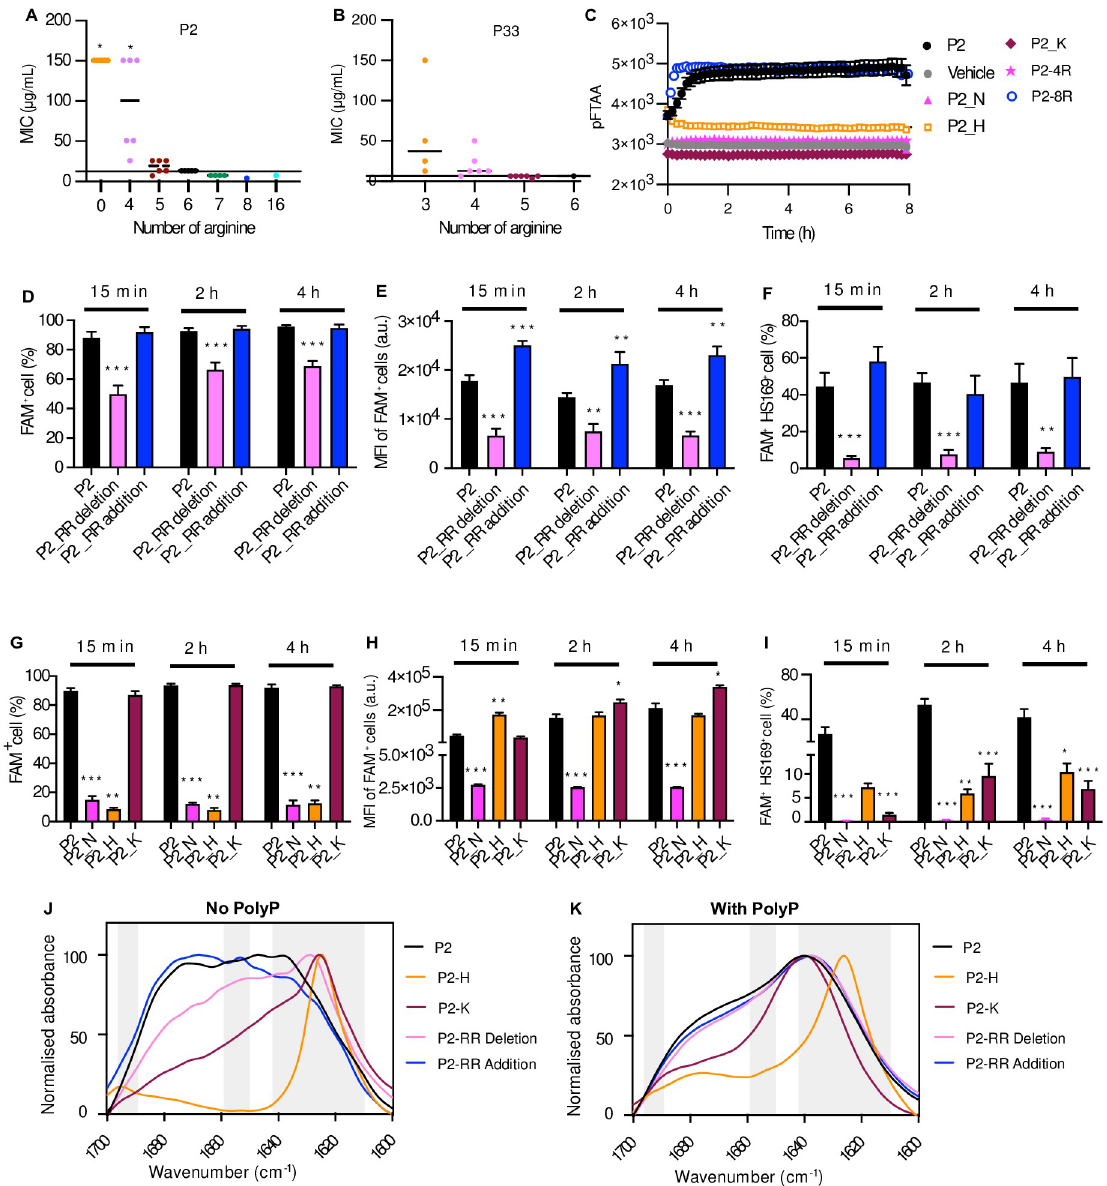
Fig 1. Arginine is essential for Pept-in mediated antimicrobial activity. A-B: MIC of P2 ( A ) and P33 ( B ) variants generated by modifying the amount of arginine against E . coli BL21. These two figures are associated with data from S1 and S2 Tables, respectively. Each dot represents the MIC of one Pept-in design. C: Time dependence of pFTAA (0.5 μ M) fluorescence intensity of P2 derivatives (50 μ M) in the presence of polyP (0.5 mM). (Error bars represent SEM, n = At least 3). D-I: Flow cytometry analysis of E . coli BL21 treated with FAM- labelled Pept-ins for different time points from three independent experiments. Samples from D-E were acquired using BD Fortessa X-20, whereas samples from G-I were acquired using Gallios Flow Cytometry. The percentage of FAM positive cells ( D ), FAM MFI of FAM positive cell population ( E ), and the percentage of FAM and HS169 positive cells ( F ) when treated with P2 or its derivatives with a reduced or an increased amount of arginine residues at the concentration of FAM-P2 RR addition MIC. The percentage of FAM positive cells ( G ), FAM MFI of FAM positive cell population ( H ), and the percentage of FAM and HS169 positive cells ( I ) when treated with P2 or its derivatives with replaced gatekeepers at the concentration of FAM-P2 MIC (25 μ g/mL). Error bars represent SEM for (D-I), n = 9 in D, E and F, n = at least 3 in G, H and I. J-K: FTIR spectrum of P2 variants with altered gatekeepers in PBS (6% DMSO), without ( J ) or with ( K ) the presence of polyP. The absorbance is normalised between all samples and the spectrum is scaled to the amide I region between 1600– 1700 cm − 1 . Peaks within the left (1689–1696 cm − 1 ) and right (1610–1642 cm − 1 ) grey bar are assigned to β -sheet, while peaks within the grey bar in the middle (1651–1659 cm − 1 ) is assigned to α -helix. The FTIR spectrums are representative of three independent experiments. For A and B , one-sample Wilcoxon signed-rank test was used to compare the MIC median of each Pept-in group to P2 MIC (12.5 μ g/mL) or P33 MIC (6.25 μ g/mL). For D-I , a two-tailed Student t-test was performed for calculating statistical significance between the mean of P2 variant